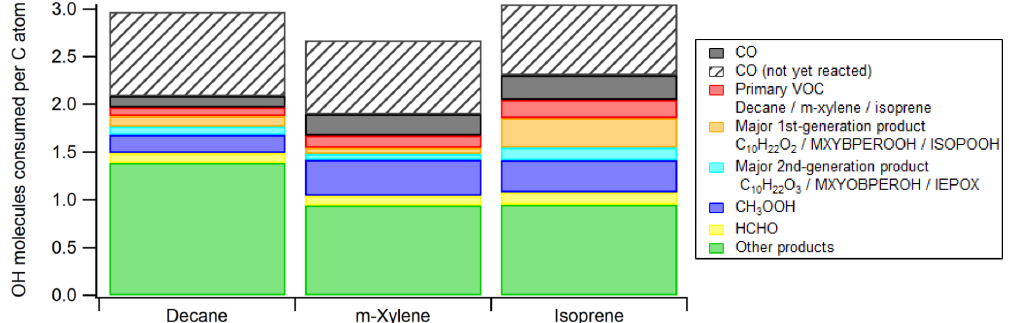
Figure 6. Average numbers of OH molecules consumed per C atom in the ambient cases with constant sunlight during photooxidation of isoprene, decane, and m -xylene. The contribution from CO that is not yet oxidized by OH at the end of simulation is also added to ensure that each CO molecule consumed one OH radical. ISOPOOH, IEPOX, C 10 H 22 O 2 , and C 10 H 22 O 3 are isoprene hydroxyl hydroper- oxides, isoprene epoxydiols, decyl hydroperoxides, and hydroxydecyl hydroperoxides, respectively. See Scheme S1 for the structures of MXYBPEROOH and